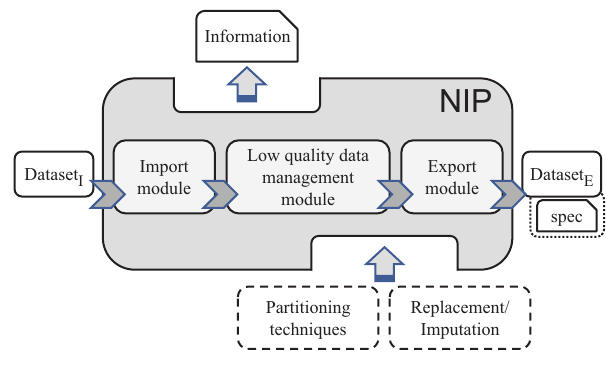
Fig. 1. NIP software tool to manage low quality data